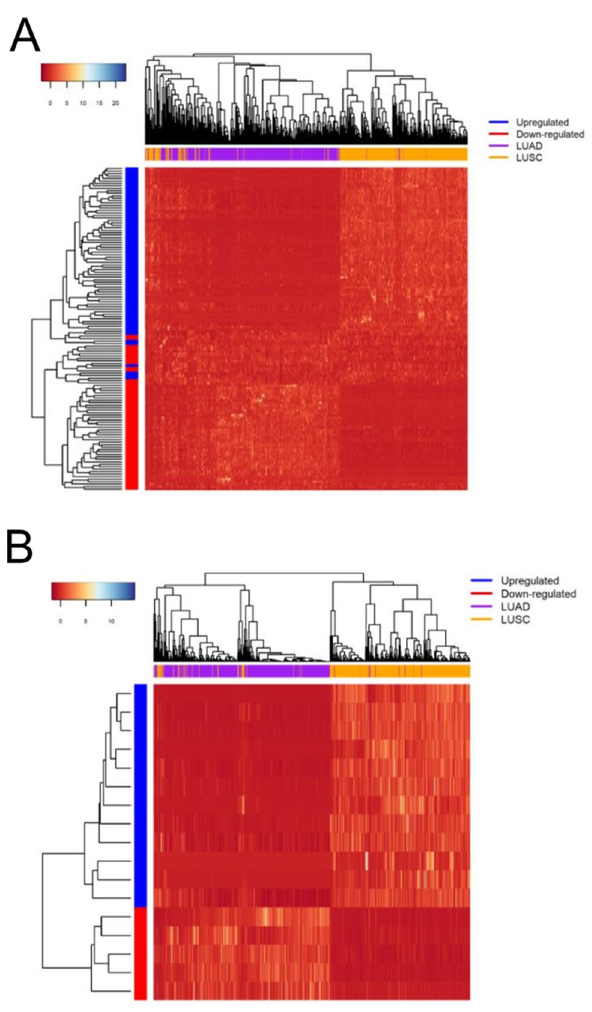
Figure 3. Heatmap shows the 131 selected genes ( A ) for gene expression analysis and the 17 selected genes ( B ) as biomarker candidates 87 . The x-axis represents the samples and the y-axis represents the